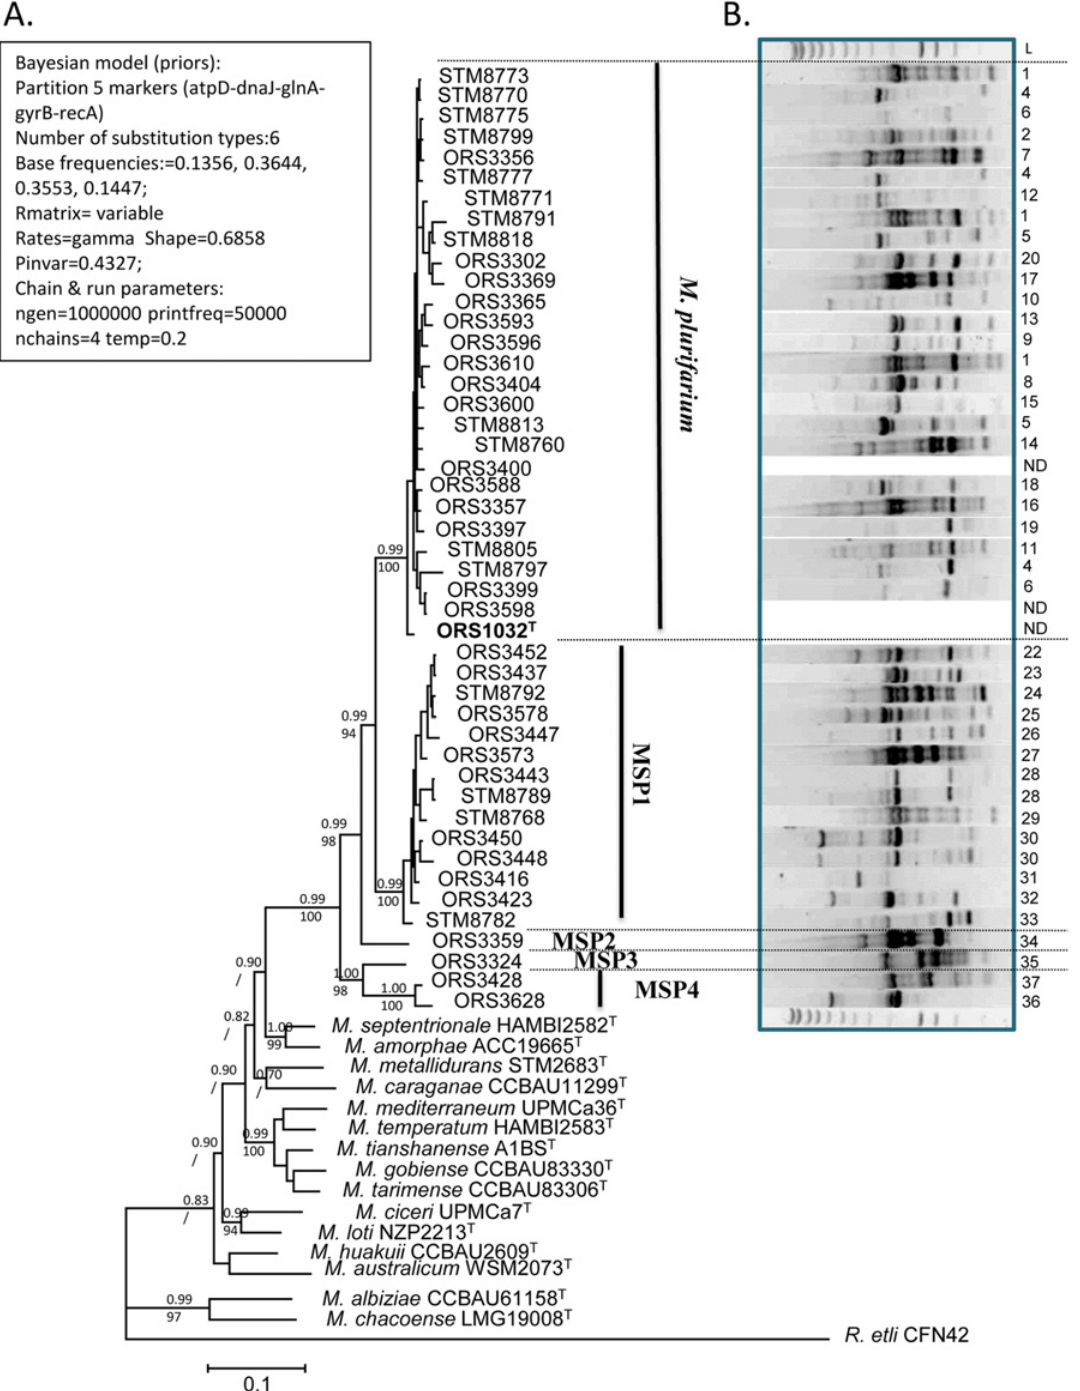
Fig 3. Bayesian phylogeny of the 5 markers alignment ( atp D- dna J- gln A- gyr B- rec A) (A) and rep-PCR fingerprints (B) of the Mesorhizobium collection. The priors (estimated by ML) and run parameters for the Bayesian phylogeny are indicated on the left side of the tree. The tree shown is a 50% majrule consensus of all trees produced by the 4 Markov chains. Posterior probabilities (upper number) and bootstraps from 1000 replicates from a ML phylogeny (below number) are indicated at each tree nodes (/ indicate that there is no bootstrap available because the tree node was not common between the Bayesian tree and the ML tree). The scale bar indicates the number of substitutions per site. For the rep-PCR fingerprints (B), see the Mat&Methods section. Each profile was numbered on the right side of the gel. Rep-PCR profiles were not obtained for ORS3400, ORS3598 and ORS1032.